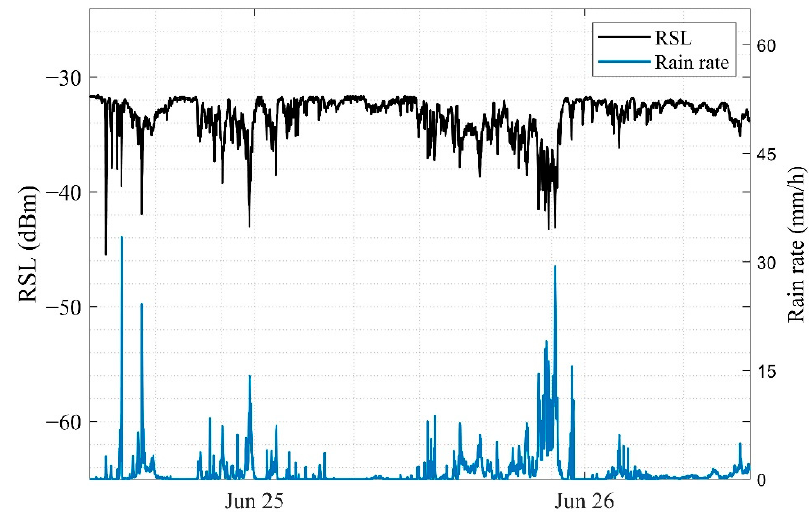
Figure 3. Correspondence between the HML signal and rainfall from 25 June to 26 June 2021. The black line is RSL of HML, and the blue line is rain rate.